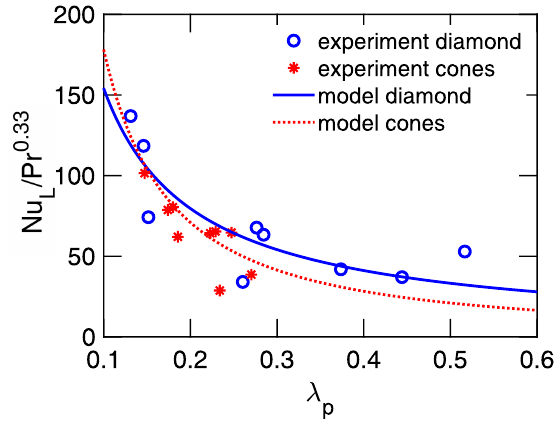
Figure 10. Influence of λ p on Nu L / Pr 0.33 for the cones and diamonds [46] micro-protruded heat sinks tested experimentally, considering an air flow with Re L , R